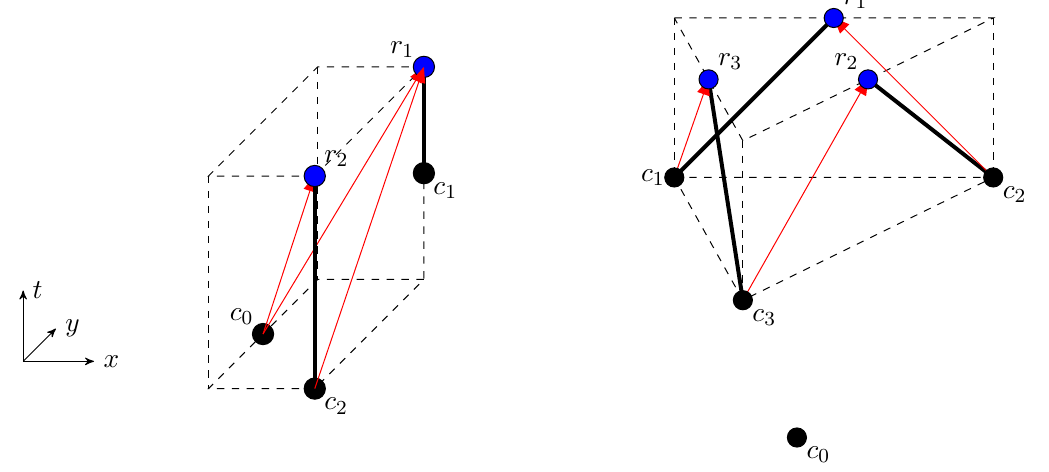
Figure 3. Two examples of quantum tasks. Red arrows indicate causal connections. In both tasks, Alice receives an unknown quantum state j i at c 0 and classical bits b i at the c i for i > 0. Exactly one of the b i will be 1, which we label by b i (cid:3) , while the others will be 0. Alice doesn’t know which will be 1 in advance. She is required to return j i at r i (cid:3) . These are known as summoning tasks [15{19]. Known protocols to complete the task at left use teleportation, while the known protocol for the task at right use an error correcting code with three shares that corrects for one erasure error. Figures reproduced from